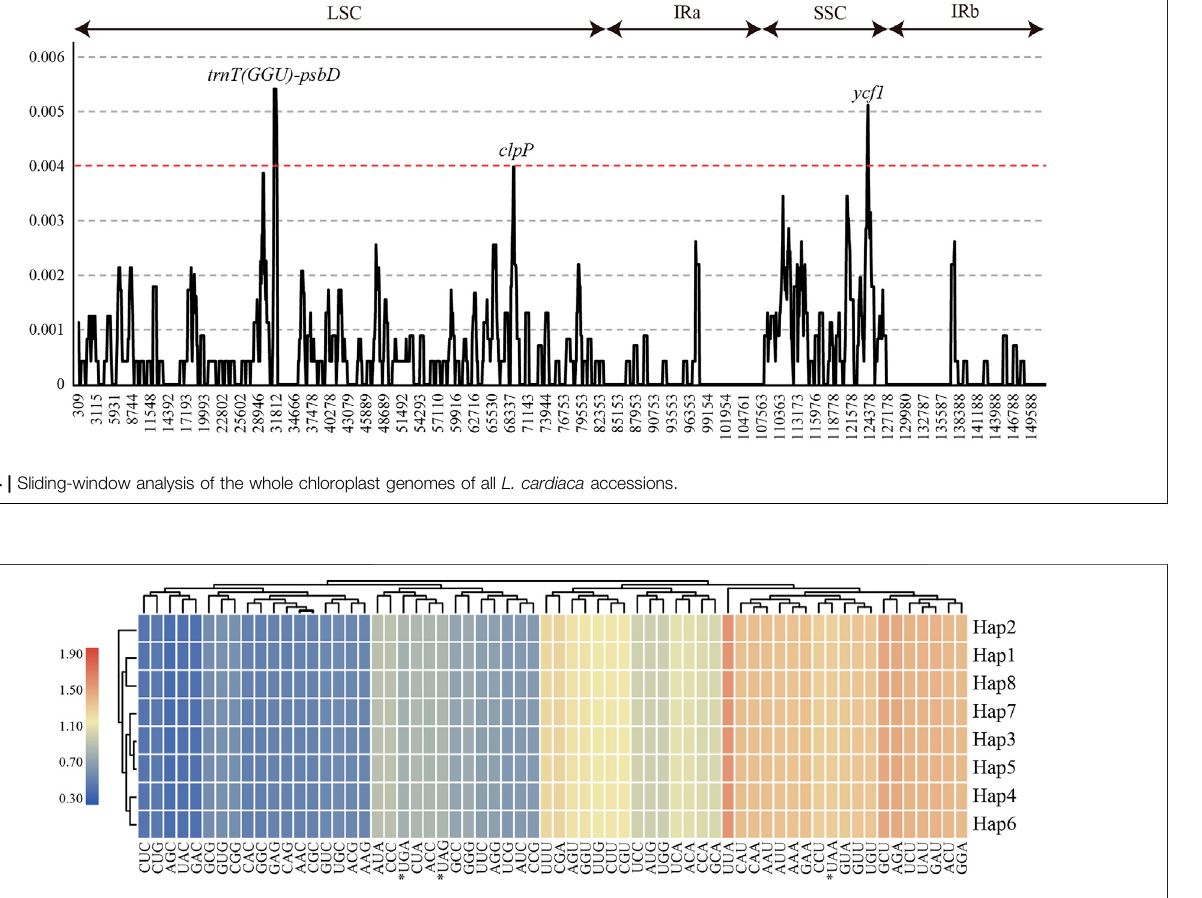
FIGURE 5 | The RSCU values of all merged protein-coding genes for eight L. cardiaca haplotypes. Color key: the red values indicate higher values and the blue values indicate lower values.